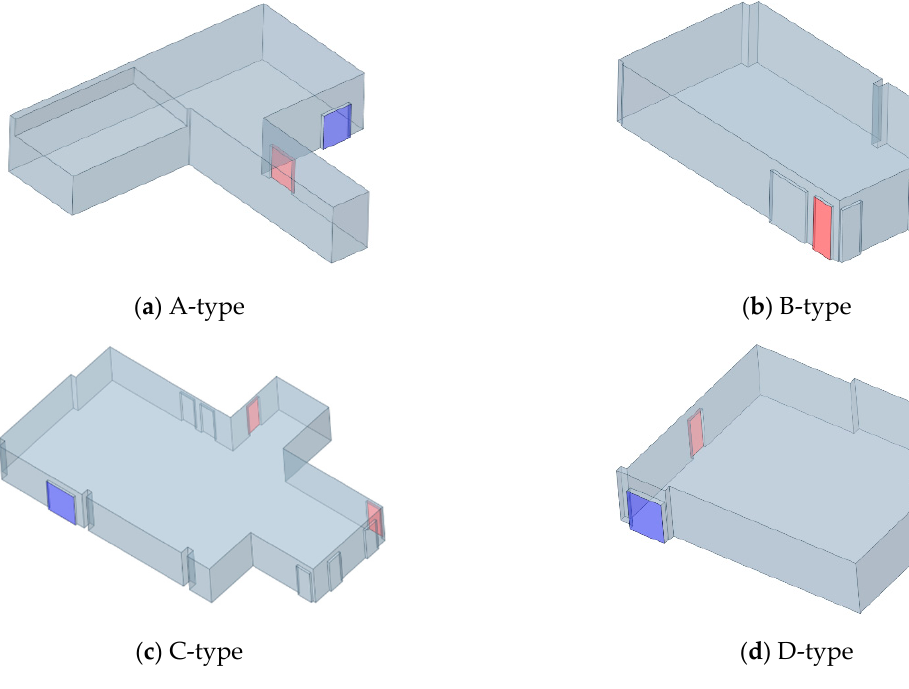
Figure 3. Target geometry model for validation.